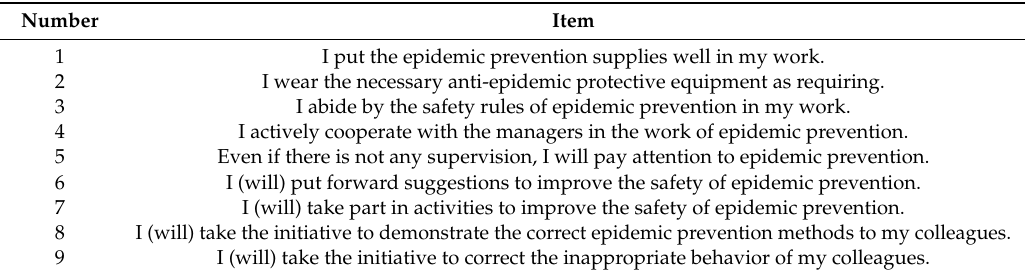
Table 1. The COVID-19 safety behavior scale.